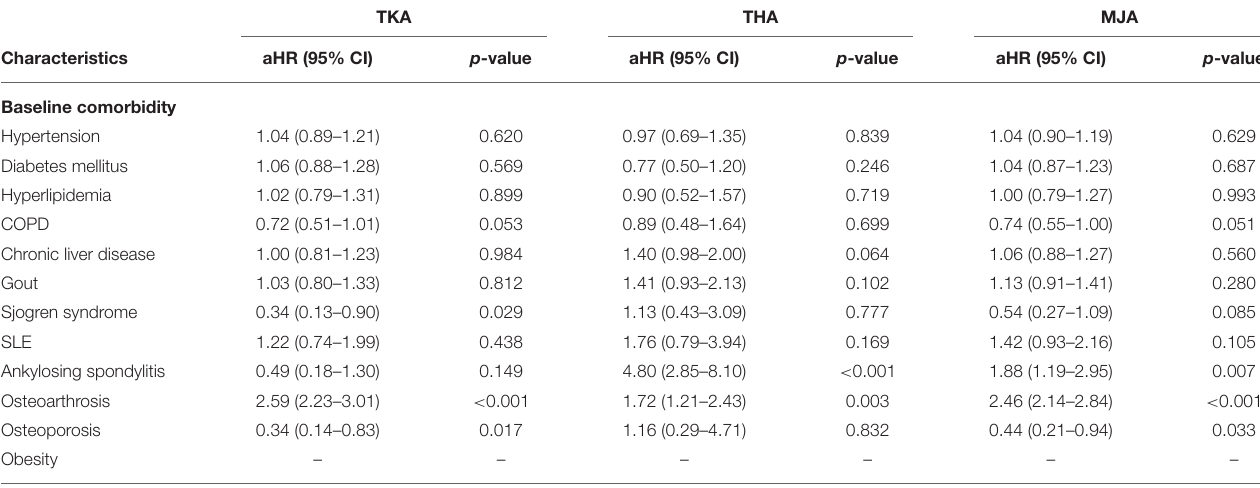
TABLE 3 | Cox model measured hazard ratio and 95% confidence intervals of TKA, THA, or MJA associated with and without comorbidities among rheumatoid arthritis (RA) patients. TKA THA MJA Characteristics